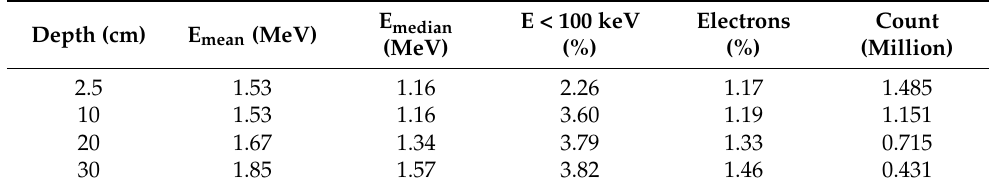
Table 2. Characteristics of megavoltage (MV) beam collected at different depths as plotted in Figure 6. E mean and E median are the mean and median energy, respectively. E < 100 keV is the percent of particles in the beam with energy less than 100 keV. Additionally, shown is the percentage of electrons contained in the beam and the total number of particles (Count) at each depth.